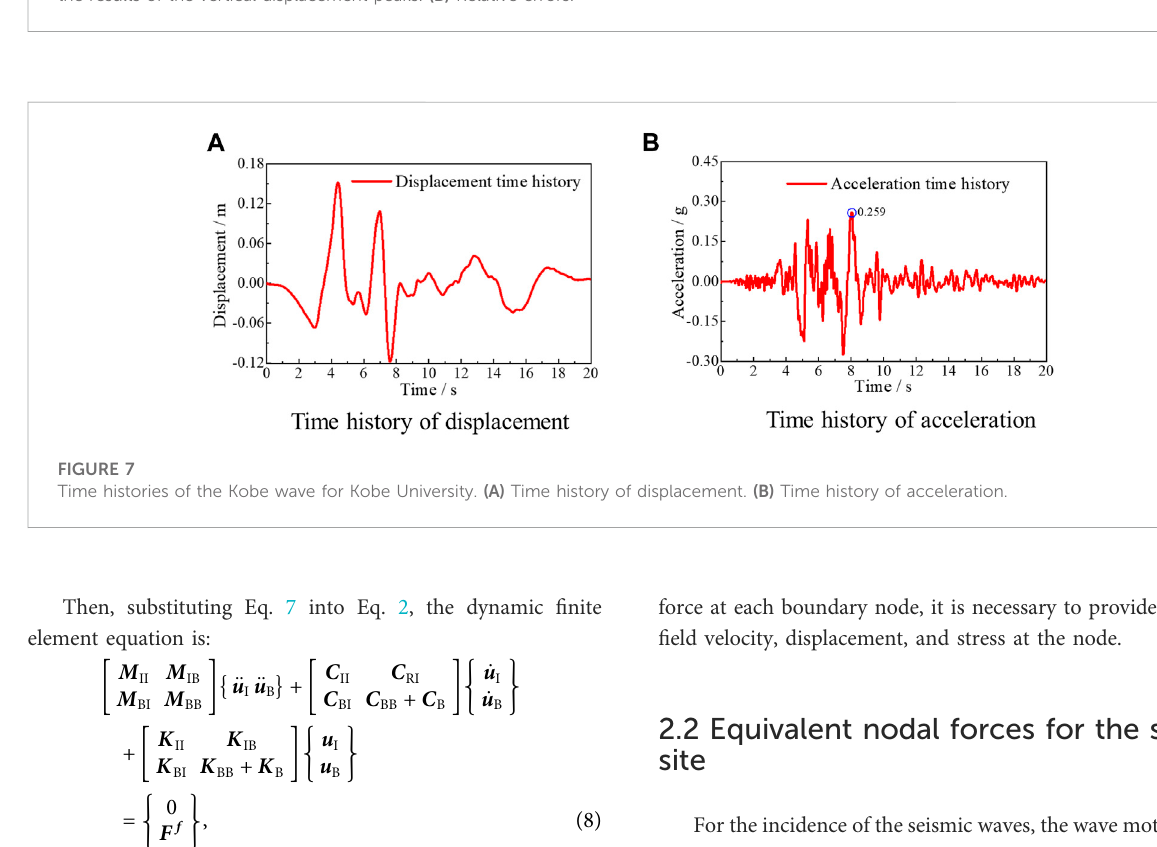
FIGURE 6 Comparisonoftheresultsandrelativeerrorsoftheverticaldisplacementpeaksofeachobservationnodeonthefreesurface. (A) Comparisonof the results of the vertical displacement peaks. (B) Relative